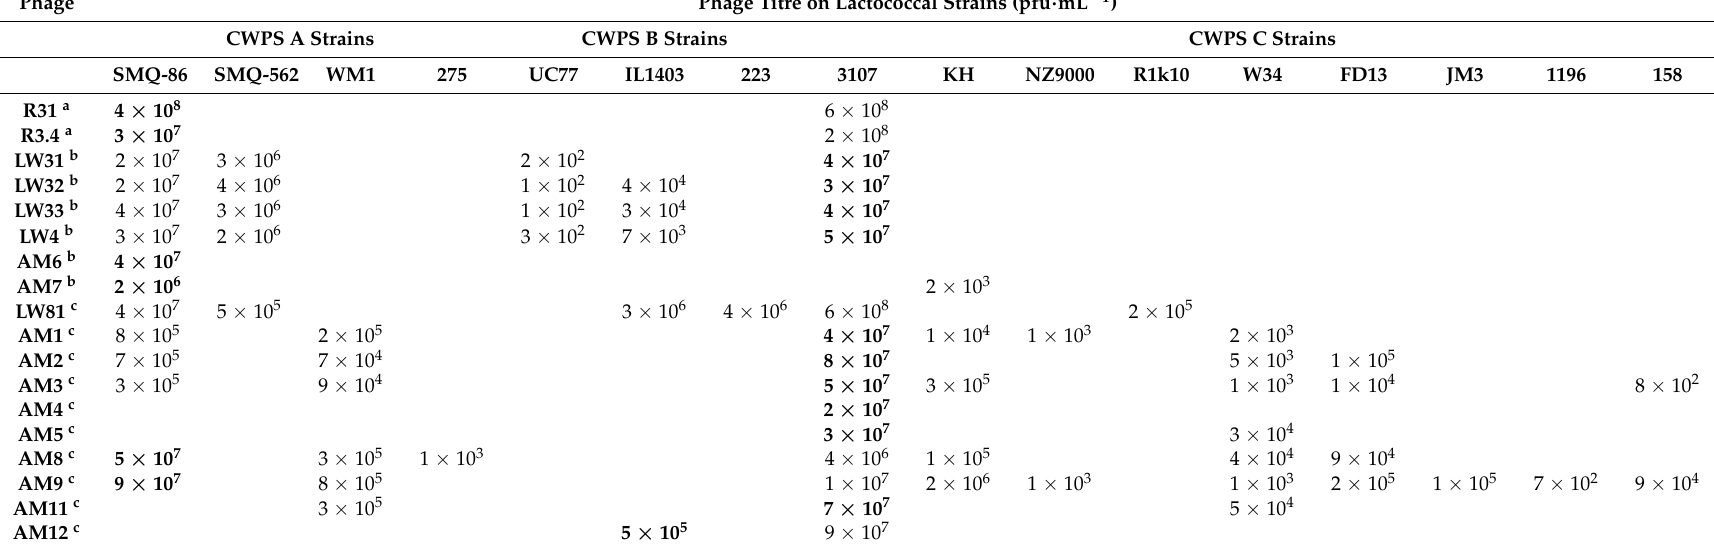
Table 4. Host range of the sequenced